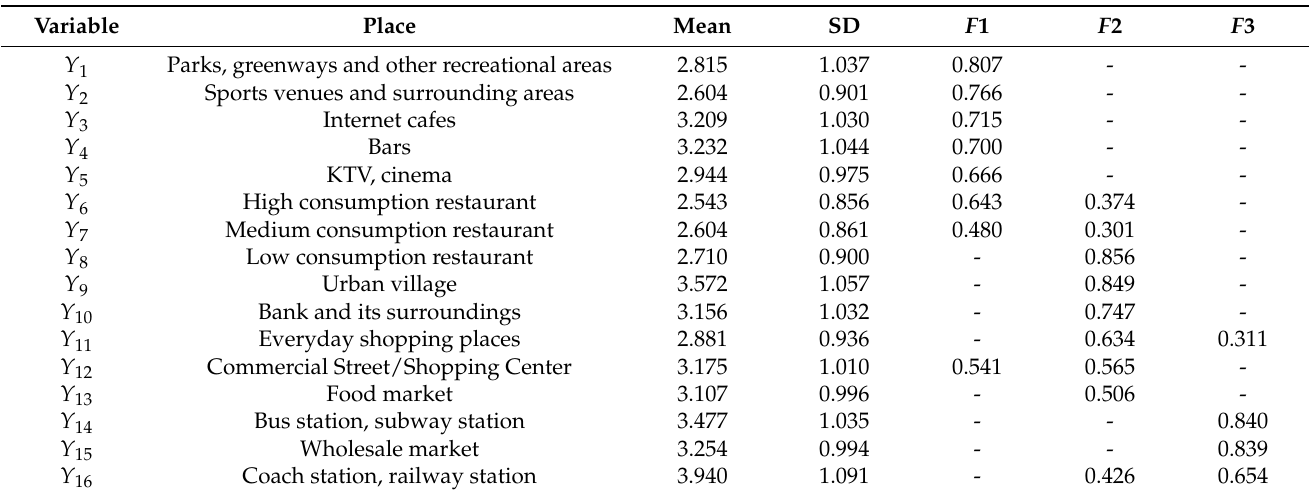
Table 1. Measurement of fear of theft and its rotated component